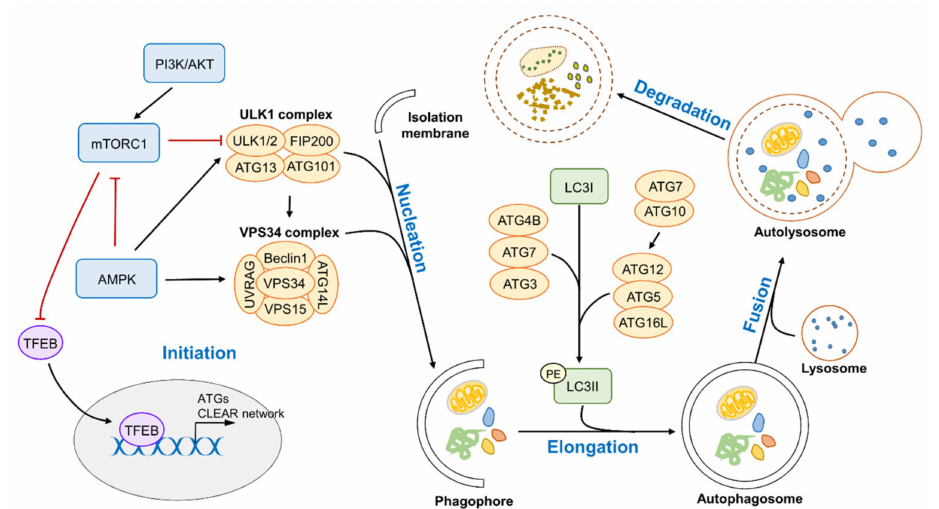
Figure 1. The main pathway for autophagy modulation. The several groups of autophagy-related genes including ULK1 complex, VPS34 complex, and ATG12-ATG5-ATG16L complex involved in autophagosome formation. Depletion of growth factor and / or nutrient cause the inactivation of mammalian target of rapamycin complex 1 (mTORC1) that acts as an autophagy suppressor by inhibiting ULK1 genes. AMP-activated protein kinase (AMPK) positively modulates autophagy machinery via inhibition of mTORC1 and activation of either ULK1 complex or VPS34 complex. ER-stress mediated unfolded protein response (UPR) stimulates AMPK-driven autophagy and is also involved in the process for autophagosome formation (not shown). Activated ULK1 complex resulted in activating VPS34 complex, facilitating the autophagy process including nucleation and elongation. Conversion of LC3I into phosphatidylethanolamine (PE)-LC3II, a key substrate for autophagosome membrane assembly, is mediated by two ubiquitin-like conjugation systems including ATG4B, ATG7, ATG3, and ATG12-ATG5-ATG16L complex. Subsequently, closed autophagosome fuses with lysosome to form an autolysosome, which leads to autophagy degradation of cytoplasmic components. This process is sustained by preventing the mTORC1-mediated phosphorylation of transcription factor EB (TFEB), which induces the expression of genes involved in autophagosome and lysosome biogenesis. CLEAR, coordinated lysosomal expression and regulation motif; PI3K, phosphoinositide-3-kinase; AKT, protein kinase B; UVRAG, UV radiation resistance-associated gene